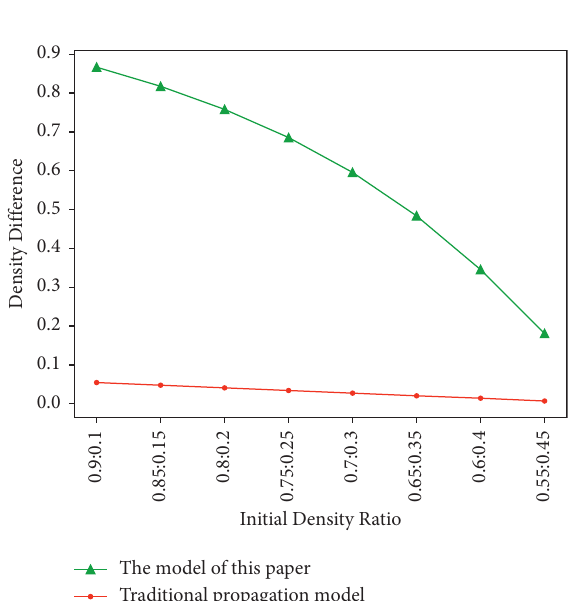
Figure 10: The density difference of different types of propagators when the information reaches the maximum spread